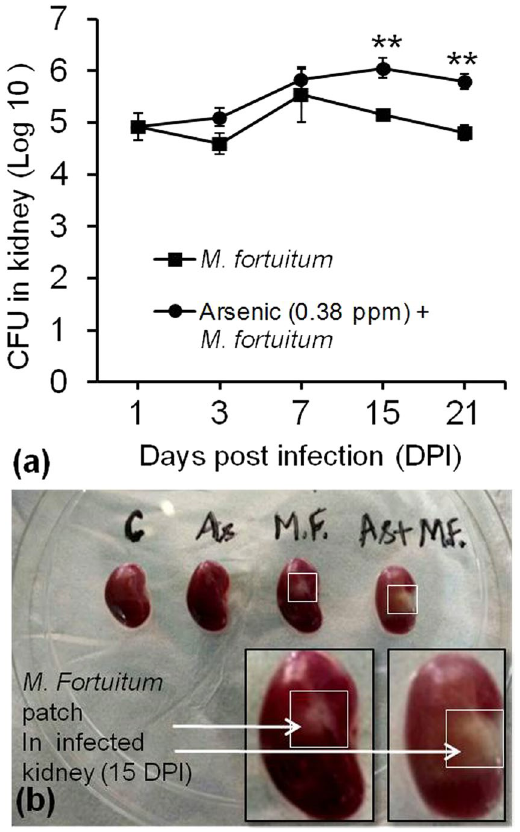
Figure 7. Effect of arsenic exposure on pathogen clearance. Mice exposed to 0.38 ppm arsenic for 30 days were infected with 10 7 of pathogen and sacrificed following 3, 7, 15 and 21 days post infection (DPI). Dissected kidney from infected mice were homogenized and plated for colony forming unit (CFU) estimation. (a) The number of M. fortuitum CFU in kidney represented as mean ± S.E of Log 10 (n = 3 per group). (b) Representative photomicrographs of visible M. fortuitum patches on kidney following 15DPI. * p < 0.05, ** p < 0.01 and *** p < 0.001 compared to M. fortuitum